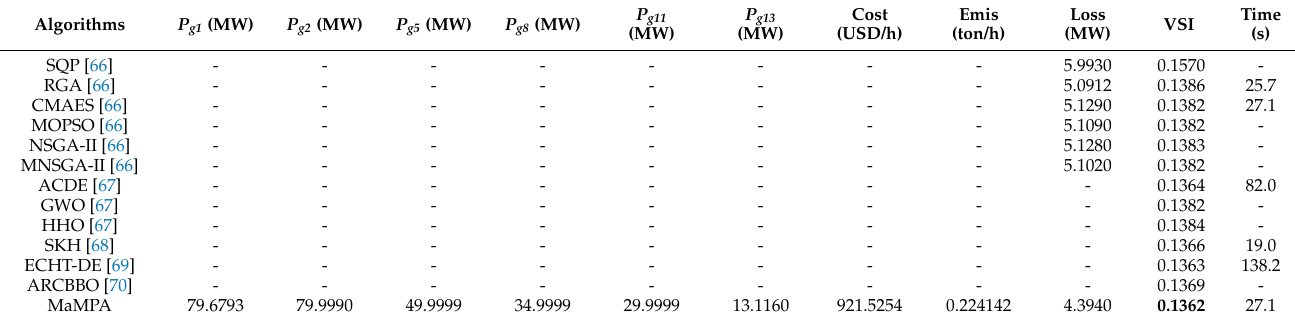
Table 5. Comparison results of case